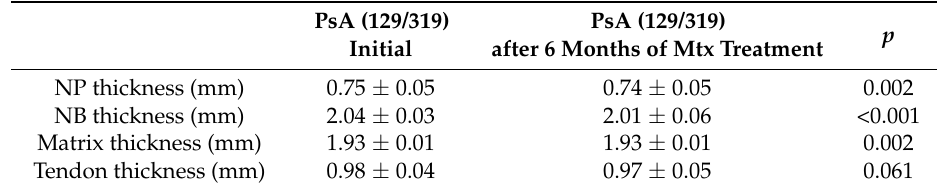
Table 5. US measurements of the fingers in patients with psoriatic arthritis.